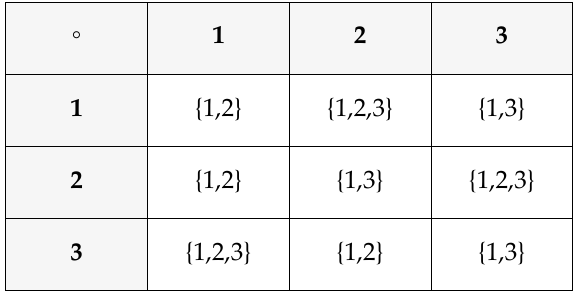
Table 8. Transposition right almost-hypergroup.